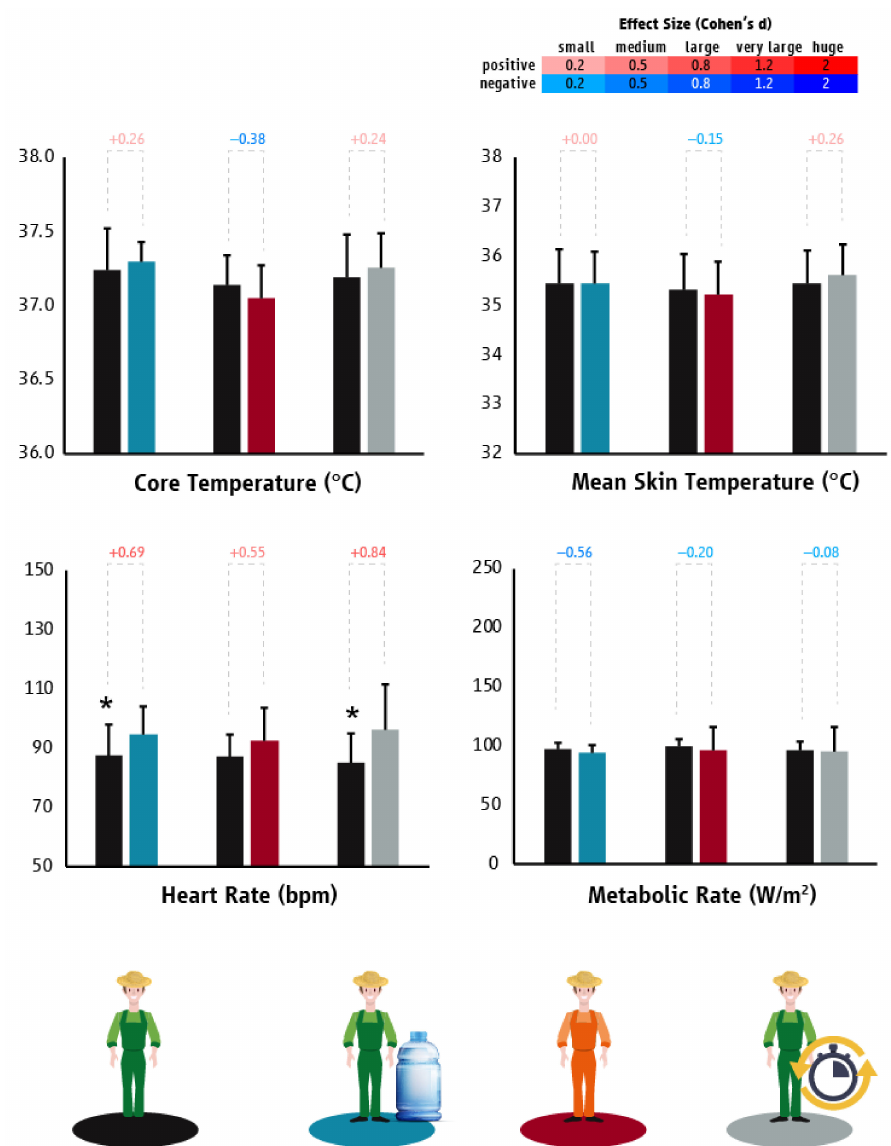
Figure 6. Differences (mean ± SD) in core temperature, mean skin temperature, heart rate, and metabolic rate/work intensity between “business as usual” and the tested heat mitigation strategies in the agriculture sector of Qatar. Black, light blue, red, and grey colors represent “business as usual”, hydration, evaporative garments, and planned breaks scenarios, respectively. Asterisks indicate statistically significant differences between “business as usual” and the tested heat mitigation strategies. Cohen’s d effect sizes show the magnitude (small: 0.2; medium: 0.5; large: 0.8; very large: 1.2; huge: 2.0) and direction (positive: shades of red; negative: shades of blue) of the differences between “business as usual” and the tested heat mitigation